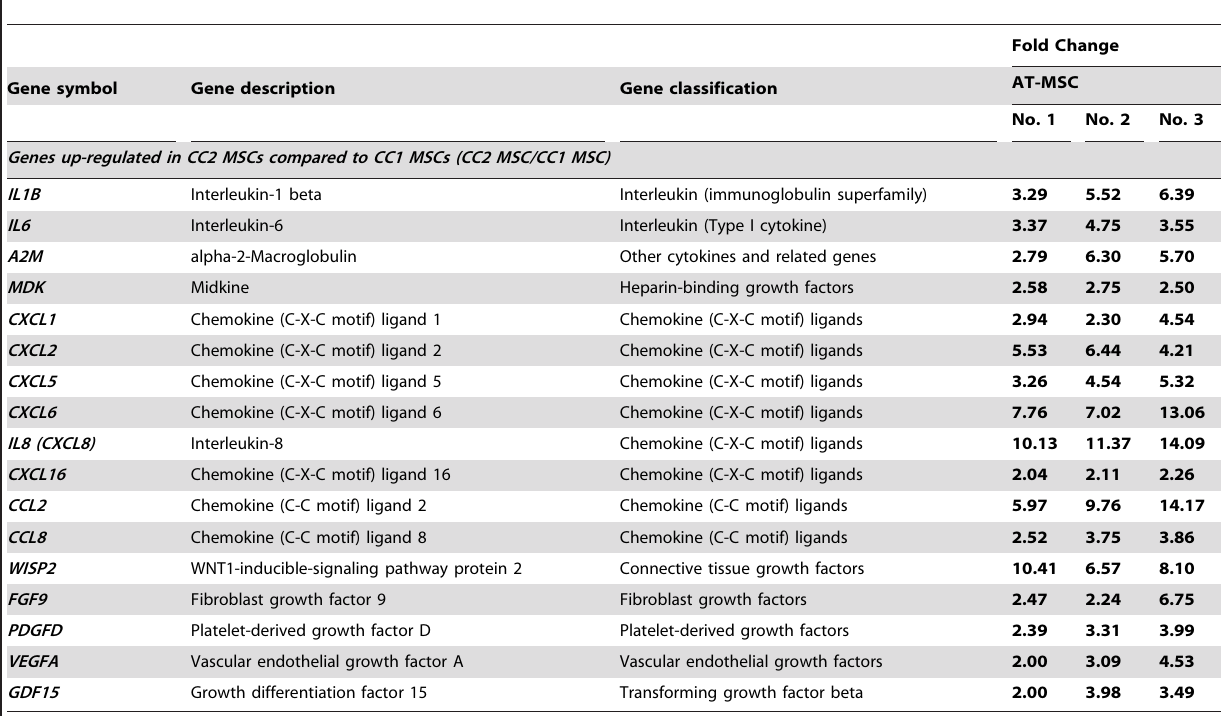
Table 2. Differentially expressed cytokine genes in AT-MSCs from three different donors, cultured to low or high density, as determined by microarray